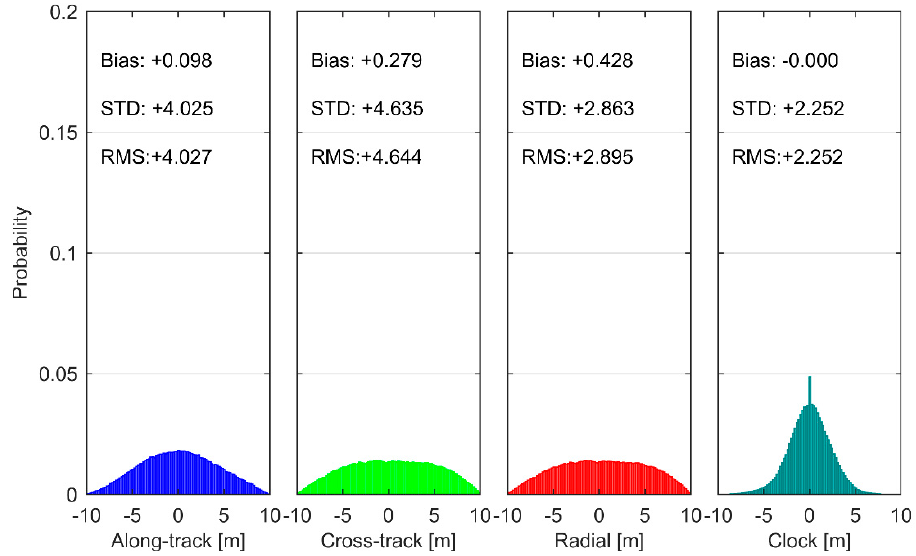
Figure 7. The distribution of SBAS-derived orbit and clock errors for MSAS PRN 137.